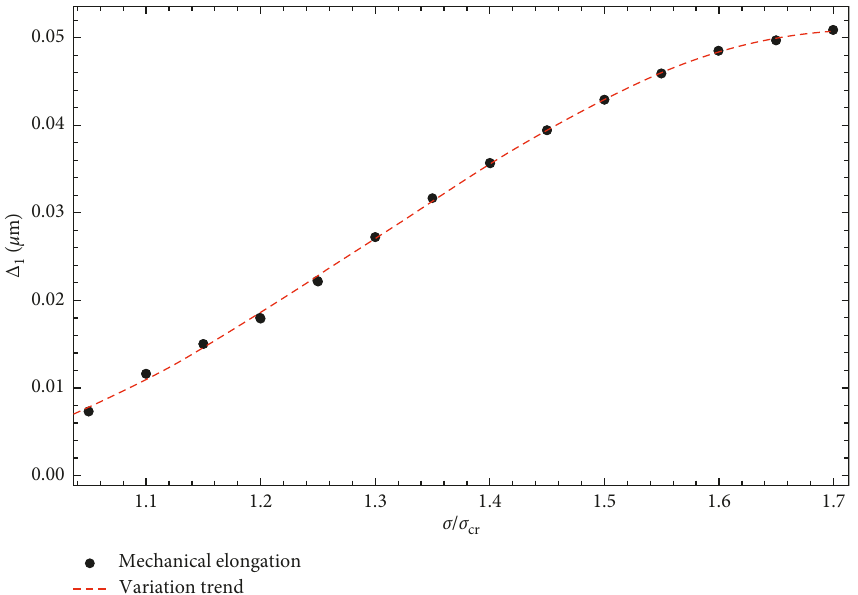
Figure 7: Variation of the main beam elongation amplitude versus central beam compressive stress level (normalized by the critical buckling stress) subjected to vibration source amplitudes corresponding to the minimum required for bistable motion at each stress level, applied at 115 Hz excitation frequency.